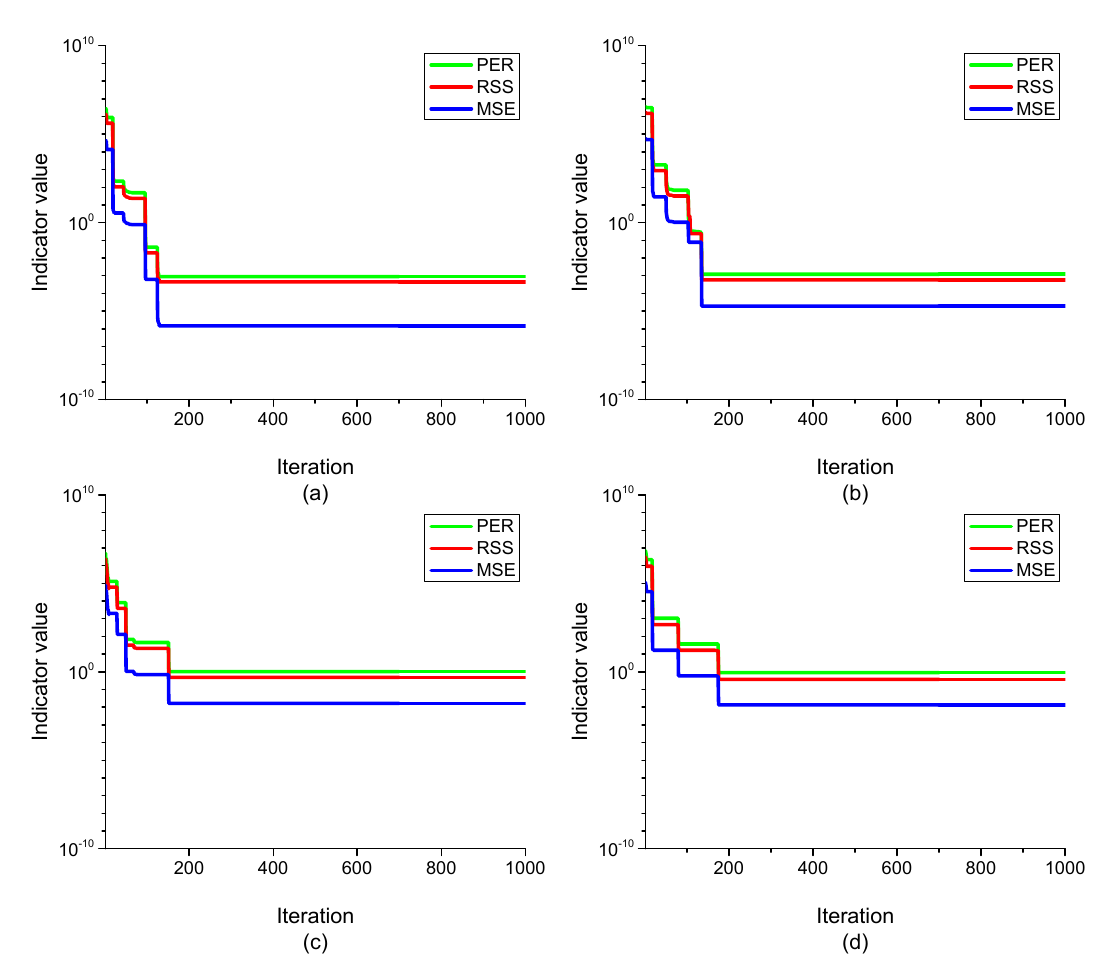
Figure 15. The convergence characteristics of the GWO-LS framework for case study II ( a ) non-noisy signal ( b ) 40 dB ( c ) 20 dB and ( d ) 10 dB.